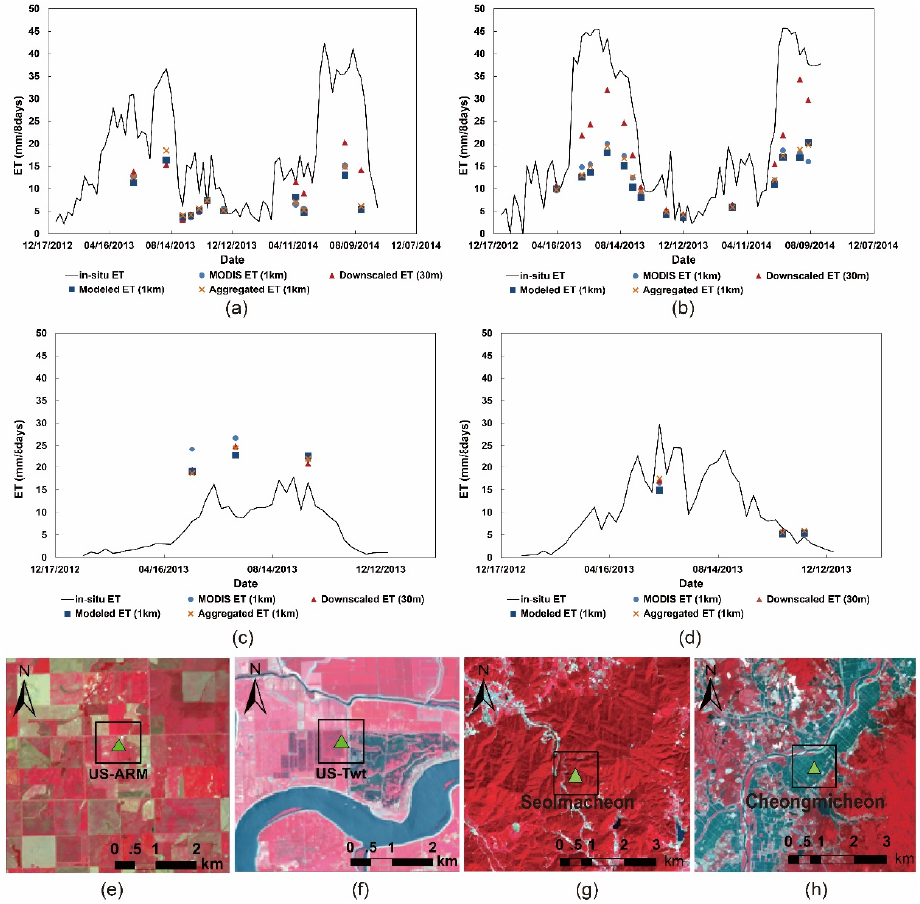
Figure 11. Comparison with in-situ ET at: ( a ) Site 1 (US-ARM flux tower); ( b ) Site 2 (US-Twt flux tower); ( c ) Site 3; and ( d ) Site 4. ( e – h ) The close view of the tower sites in July 2013 for Sites 1–3 and May 2013 for Site 4, with a black square denoting 1 km grid around each tower location: (e) Site 1; (f) Site 2; (g) Site 3; and (h) Site 4.